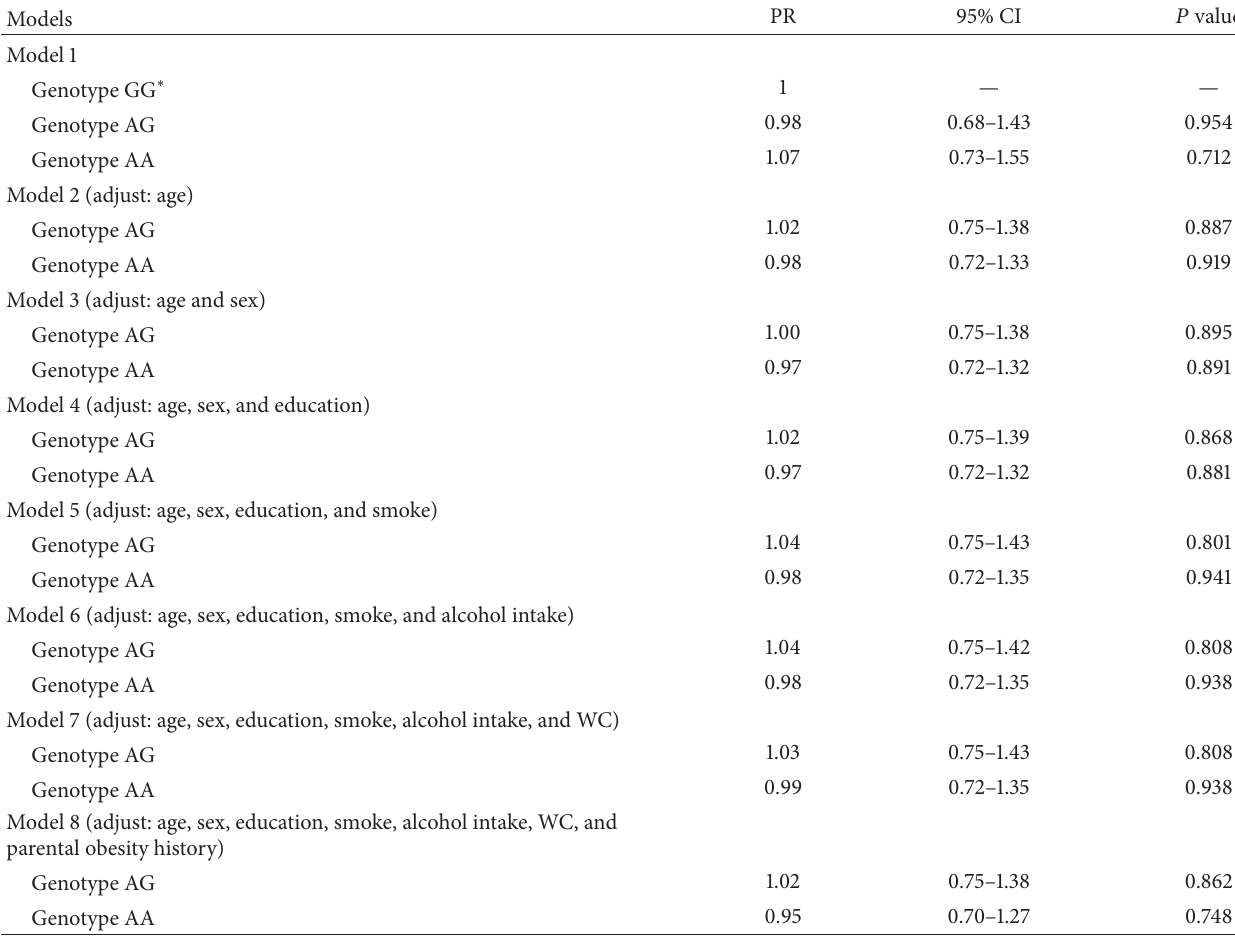
Table 3: Multivariate Poisson regression model (prevalence ratio and 95% CI) for hypertension, Montes Claros, Brazil, 2013.